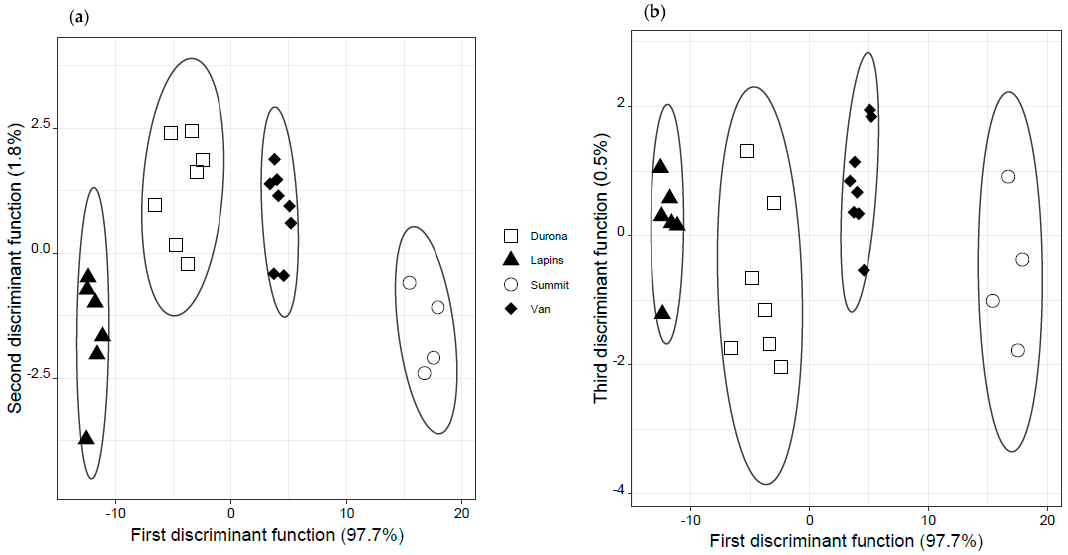
Figure 4. Discrimination of sweet cherries according to four cultivars ( (cid:3) Durona; (cid:78) Lapins; ◦ Summit; or (cid:7) Van) using a LDA-SA model based on 11 E-tongue potentiometric profiles (1st sensor array: S1:4, S1:5, S1:6, S1:7, S1:11, S1:13, and S1:17; 2nd sensor array: S2:2, S2:15, S2:18, and S2:20): ( a ) 2D-plot of the first and second discriminant functions; ( b ) 2D-plot of the first and third discriminant functions The full ellipses represent the confidence region boundaries determined based on the posterior probabilities calculated for each class membership.